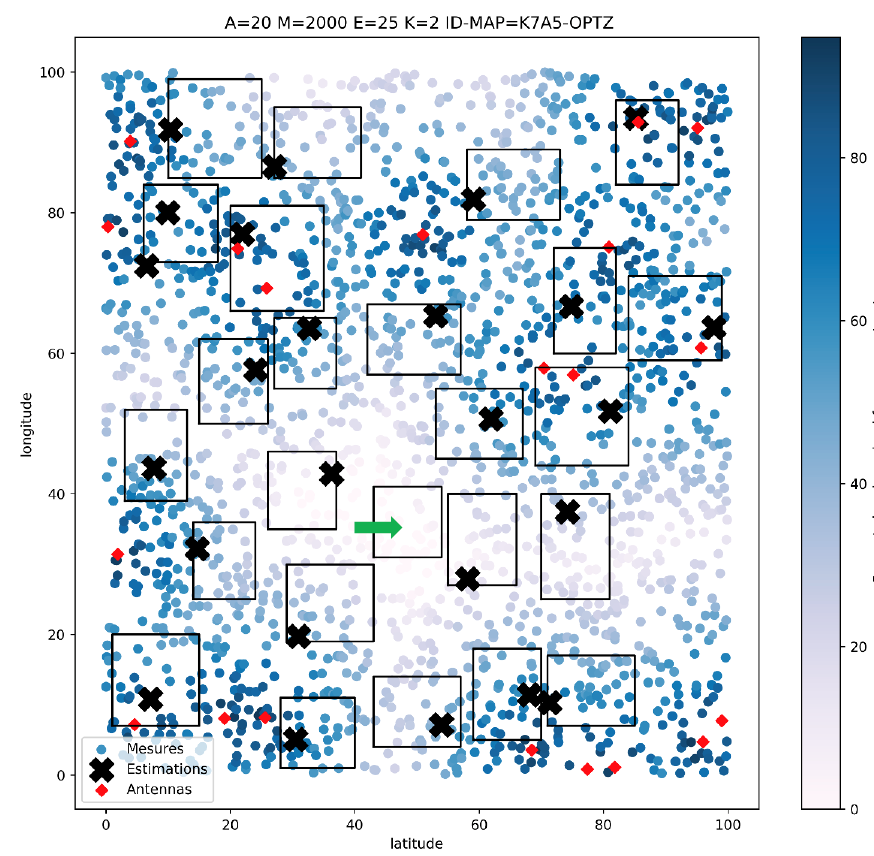
Figure 18. An example of proposed deployment for 25 areas of interest after 500